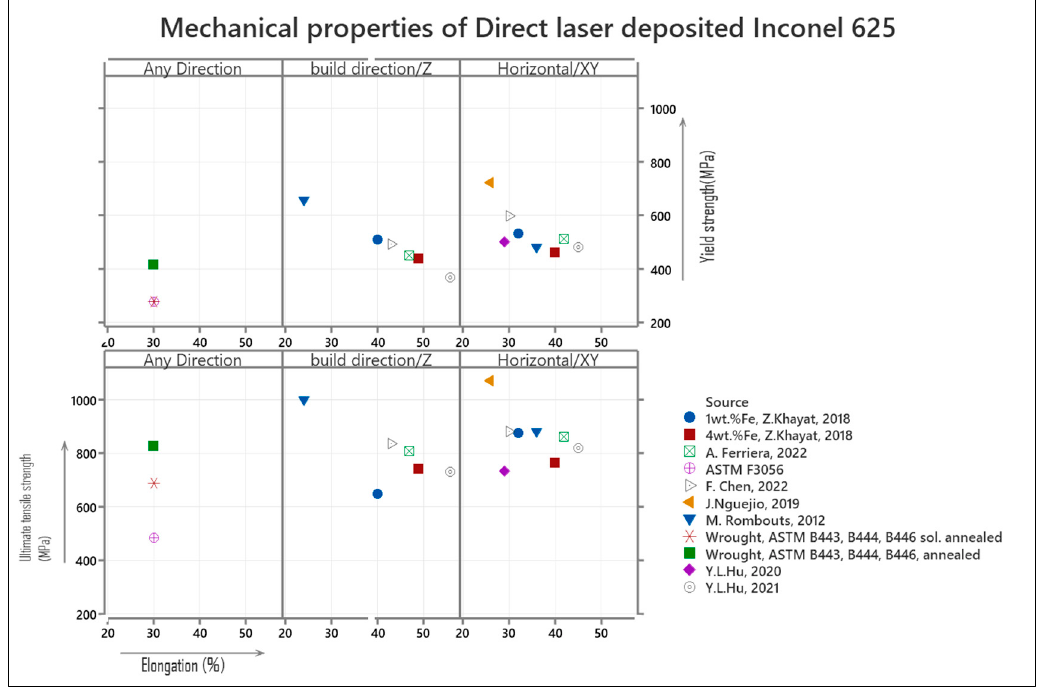
Figure 4. Mechanical properties of DLD Inconel 625 in different orientations. (data from Refs. [23–30]). DLD IN625 meets/surpasses the ultimate tensile strength (UTS), yield strength (YS), and elongation (%) specification for conventionally manufactured IN625 products.